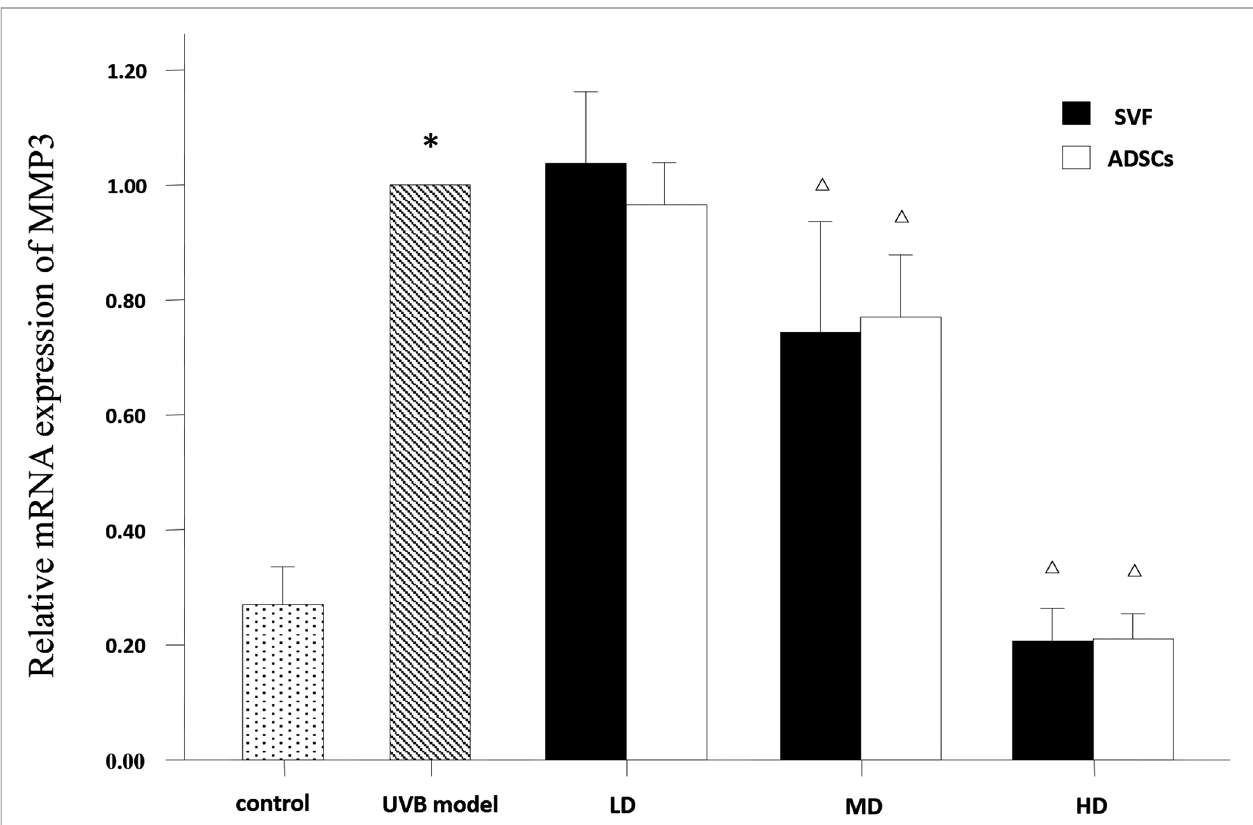
FIGURE 8 | qPCRed the relative mRNA expression of MMP3 of nude rats exposed to UVB 28 days after SVF and ADSCs treatment. Mean±SD. n =6. * P <0.05 vs control group. △ P <0.05 vs UVB model